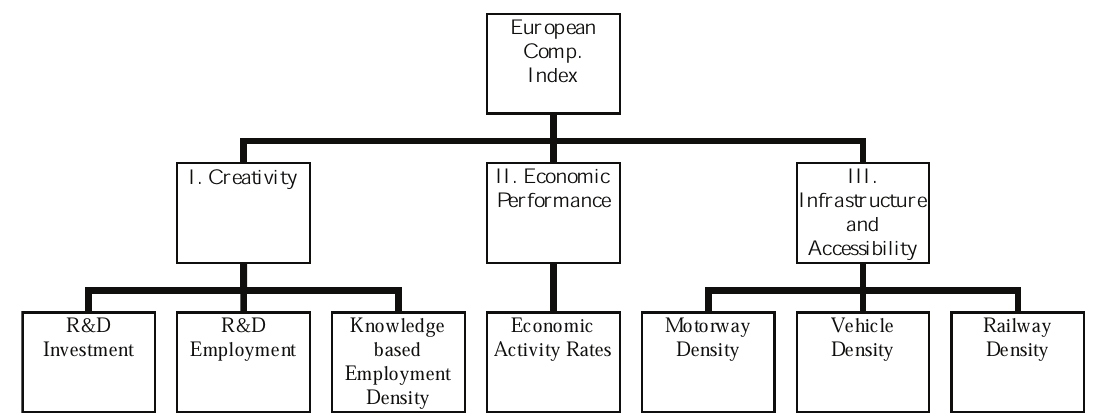
Fig. 7. The composite European Competitiveness Index. Source: Robert Huggins Associates (Huggins, Davies